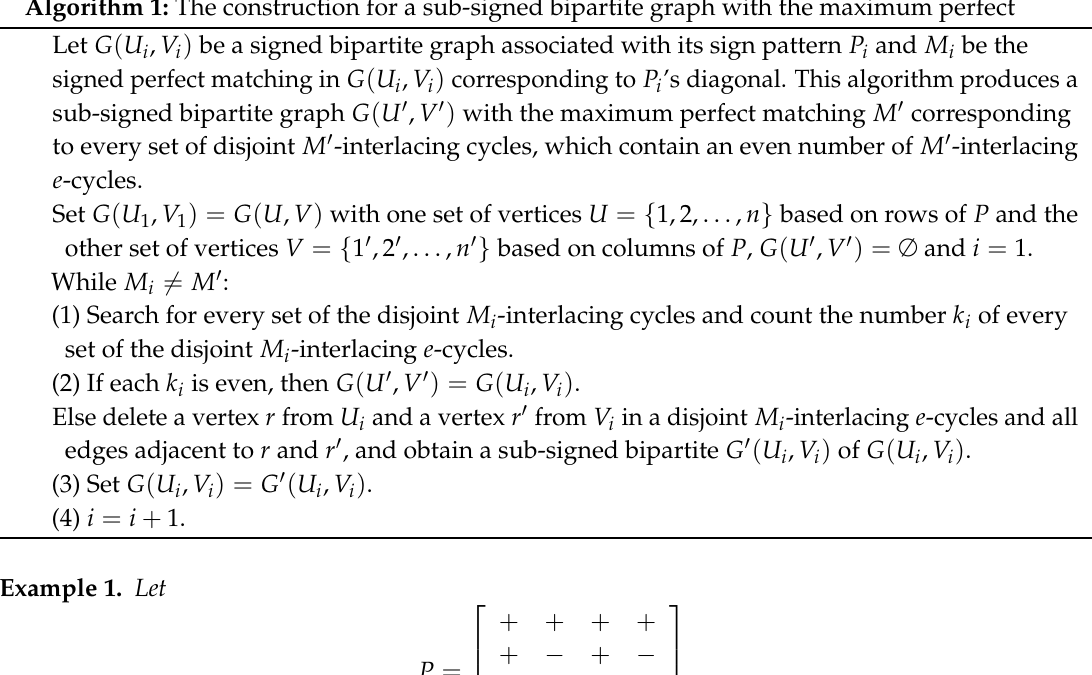
Algorithm 1: The construction for a sub-signed bipartite graph with the maximum perfect